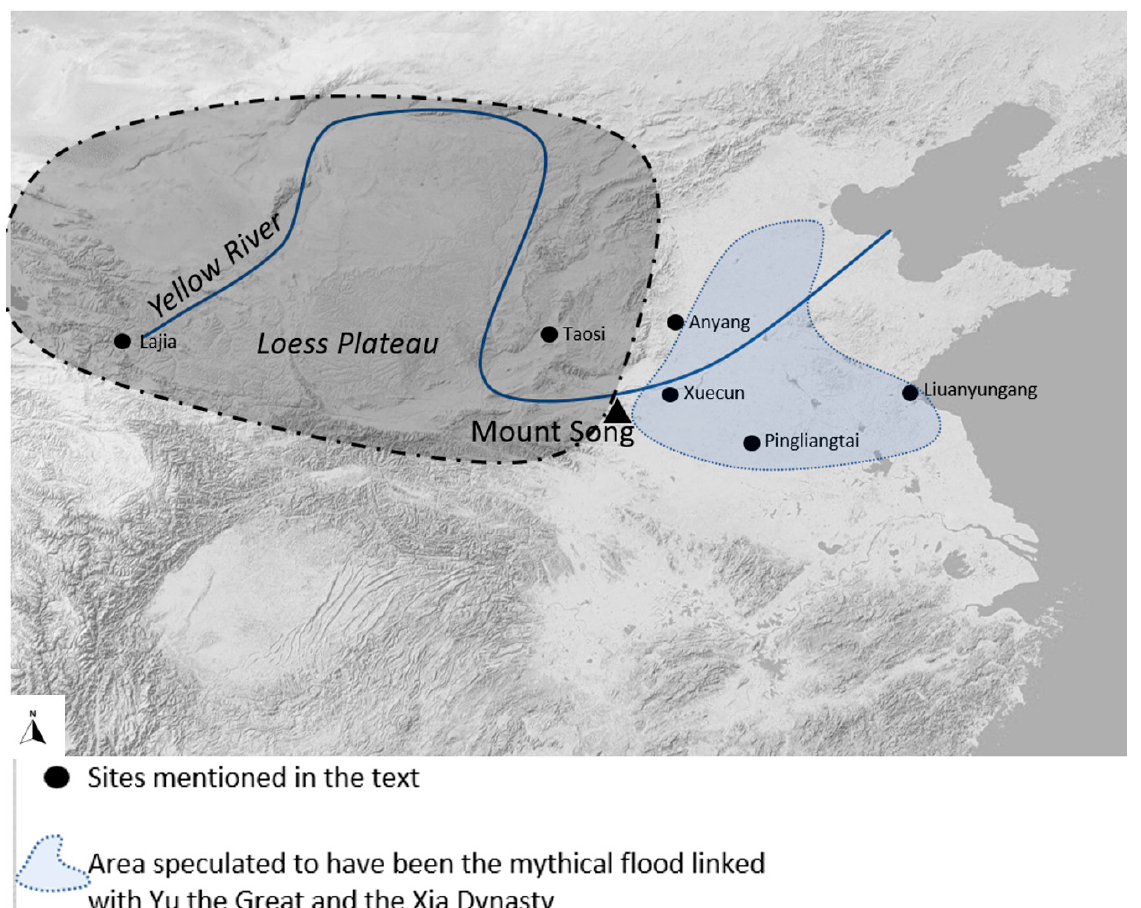
Figure 2. Map showing sites mentioned in the text and associated environmental features around the Yellow River basin such as Mount Song (triangle) (based on the flood dynamics described in [23], under a Creative Commons Attribution License). (basemap: free from Tom Patterson, US National Park Service Natural Earth), distance Taosi-Anyang = 256 km.